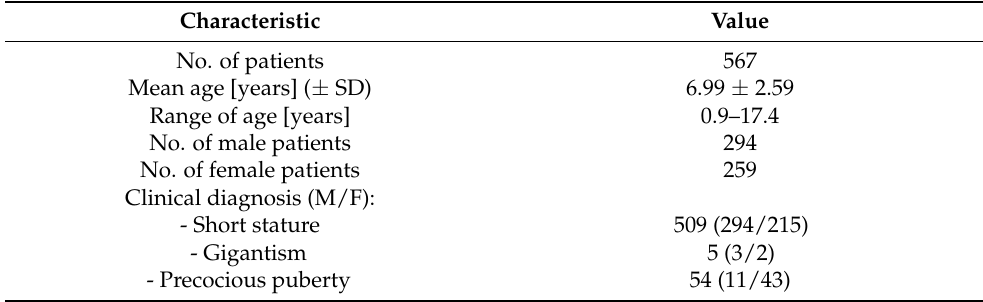
Table 1. Clinical characteristics of the patients. Data are numbers of patients, divided by gender in parentheses: